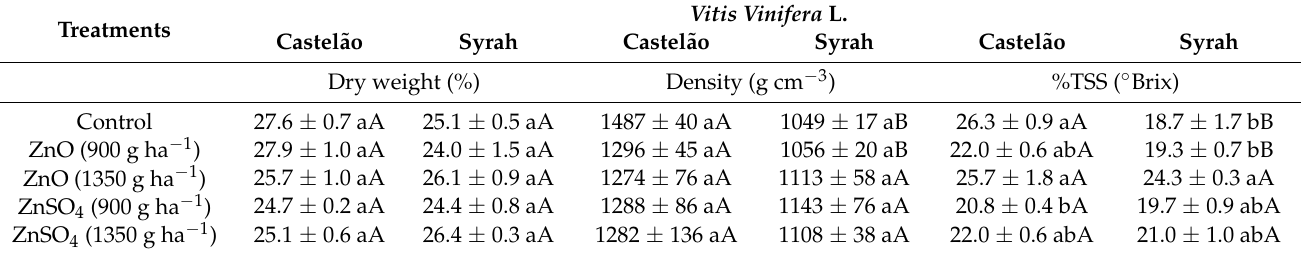
Table 4. Average ± S.E. ( n = 3) of dry weight, density, and total soluble solids (expressed as ◦ Brix) in grapes of Vitis vinifera, varieties Castel ã o and Syrah. Letters a, b indicate significant differences could among treatments in each variety, whereas letters A and B indicate the significant differences between each parameter for both varieties in each treatment (statistical analysis using the two-way ANOVA test, p <